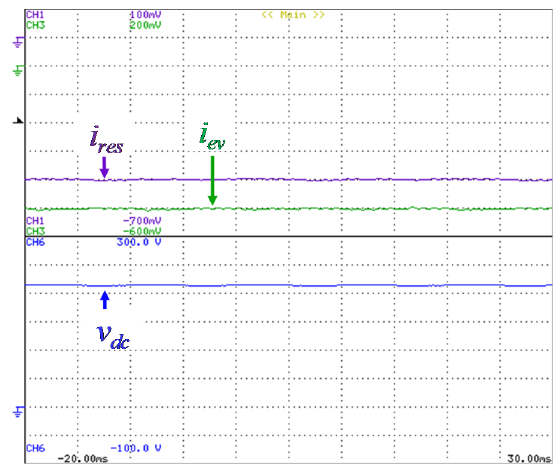
Figure 18. Experimental results during the MF-EVCS operation in R2G mode combined with V2G mode: ( a ) Harmonic spectrum of the total home current ( i g ); ( b ) Operating powers and total power factor.